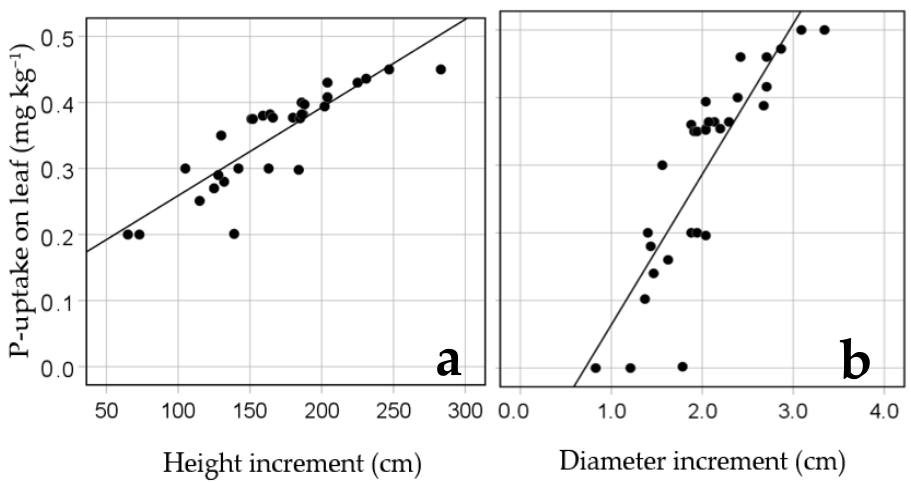
Figure 6. ( a ) correlation between P absorption on the leaf to height, and ( b ) diameter increment after six months planted in the field. The line indicated the slope and form of correlation between the two parameters.